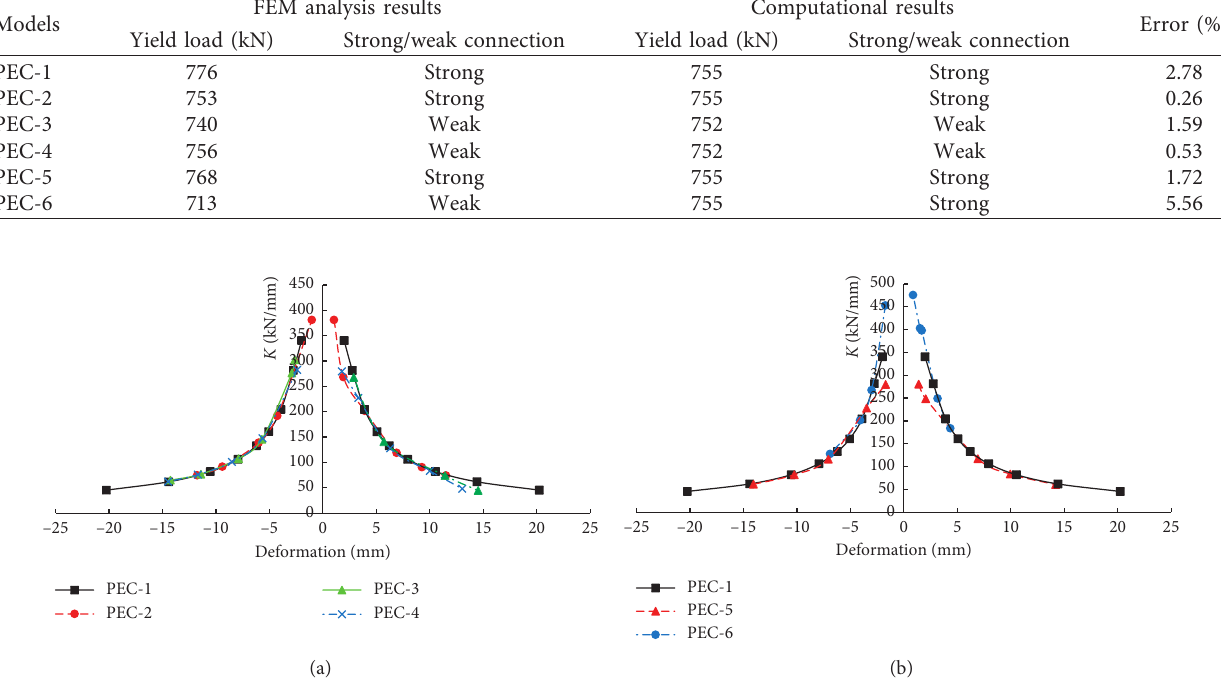
Figure 10: Stiffness of the models. (a) PEC-1, PEC-2, PEC-3, and PEC-4. (b) PEC-1, PEC-5, and PEC-6.